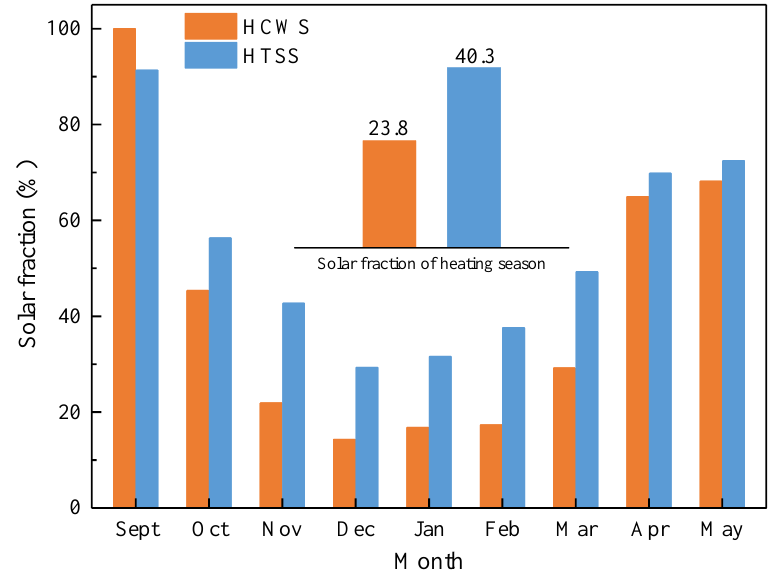
Figure 7. Comparison of monthly average solar fraction of the two modes.